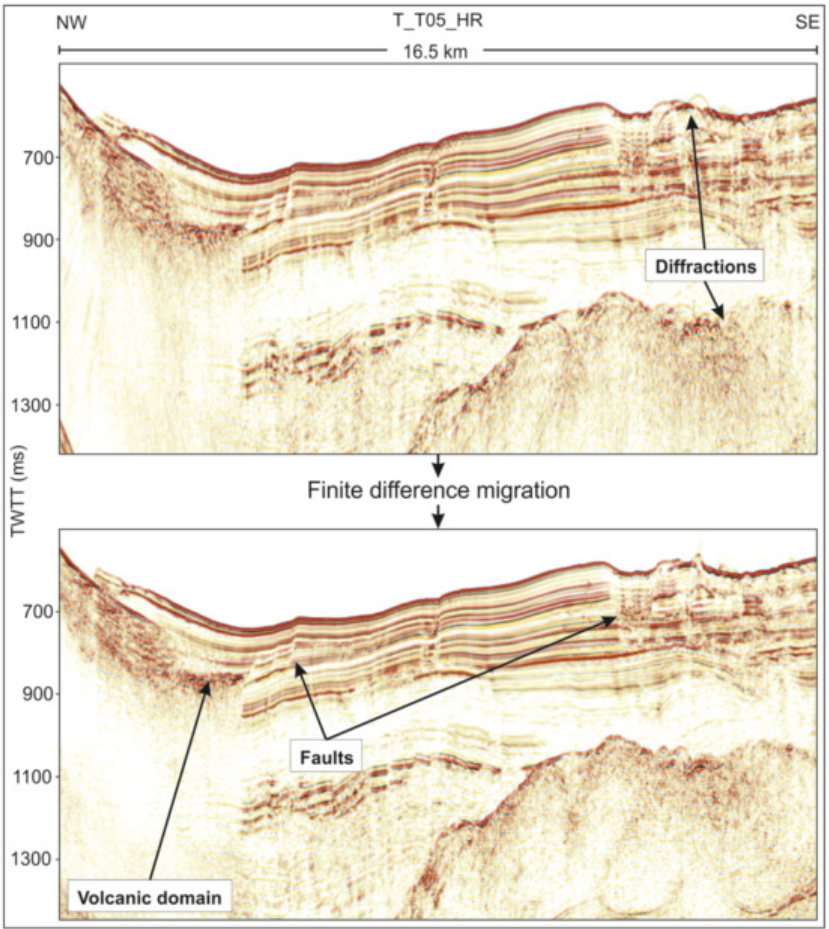
Figure 13. Unmigrated (top) and time-migrated (bottom) stacks of the T_T05_HR line (Tyrrhenian Sea, see Figure 3 for line location). Mi- gration has successfully removed some diffractions previously present in the data, showing better defined reflectors.